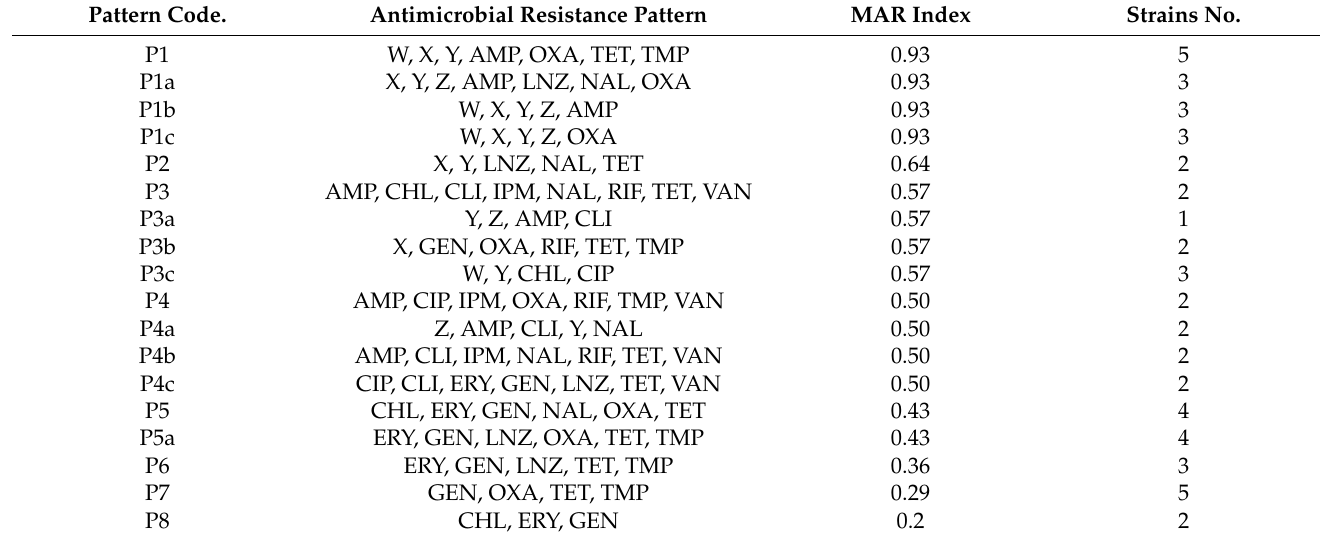
Table 2. The antimicrobial resistance patterns of MDR L. monocytogens strains ( n = 50). Pattern Code. Antimicrobial Resistance Pattern Strains